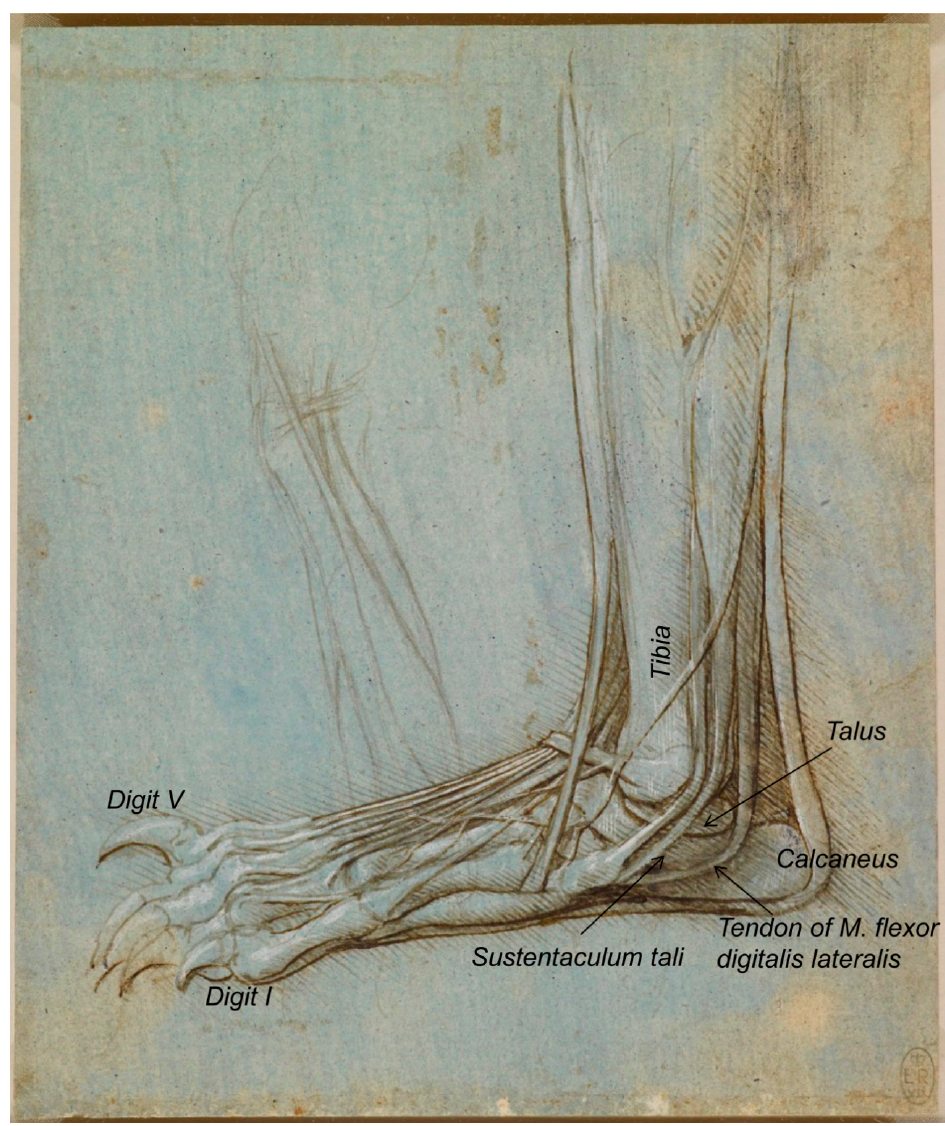
Figure 1. Bear’s foot series—Number 1. Bear distal right pelvic limb / pes , medial aspect. A bear’s foot c.1488–1490. Modified from www.rct.uk/collection/912372 (Royal Collection Trust [3]). This image is credited as Royal Collection Trust / © Her Majesty Queen Elizabeth II